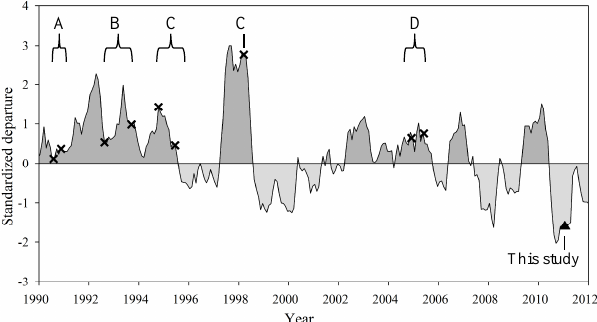
Fig. 2. Multivariate El Ni˜no–Southern oscillation Index, (MEI) be- tween January 1990 and 2012. The dark grey shaded area above the line shows the El Ni˜no condition period and light grey be- low the line is the La Ni˜na condition period. The black crosses show the previous observations conducted in the western part of North Pacific subtropical gyre. The black triangle shows the Tokyo Palau cruise (this study). A, B, C, D are the studies of Shimada et al. (1993), Suzuki et al. (1997), Horimoto et al. (2001) and Ki- tajima et al. (2009), respectively. Shimada et al. (1993) sampled seawater during two cruises (from August to September and from November to December). Suzuki et al. (1997) conducted experi- ments in August-September 1992 and 1993. Horimoto et al. (2001) collected samples during 3 cruises (October 1994, June 1995 and March 1998) and Kitajima et al. (2009) during two cruises (Novem- ber to December 2004 and May to June